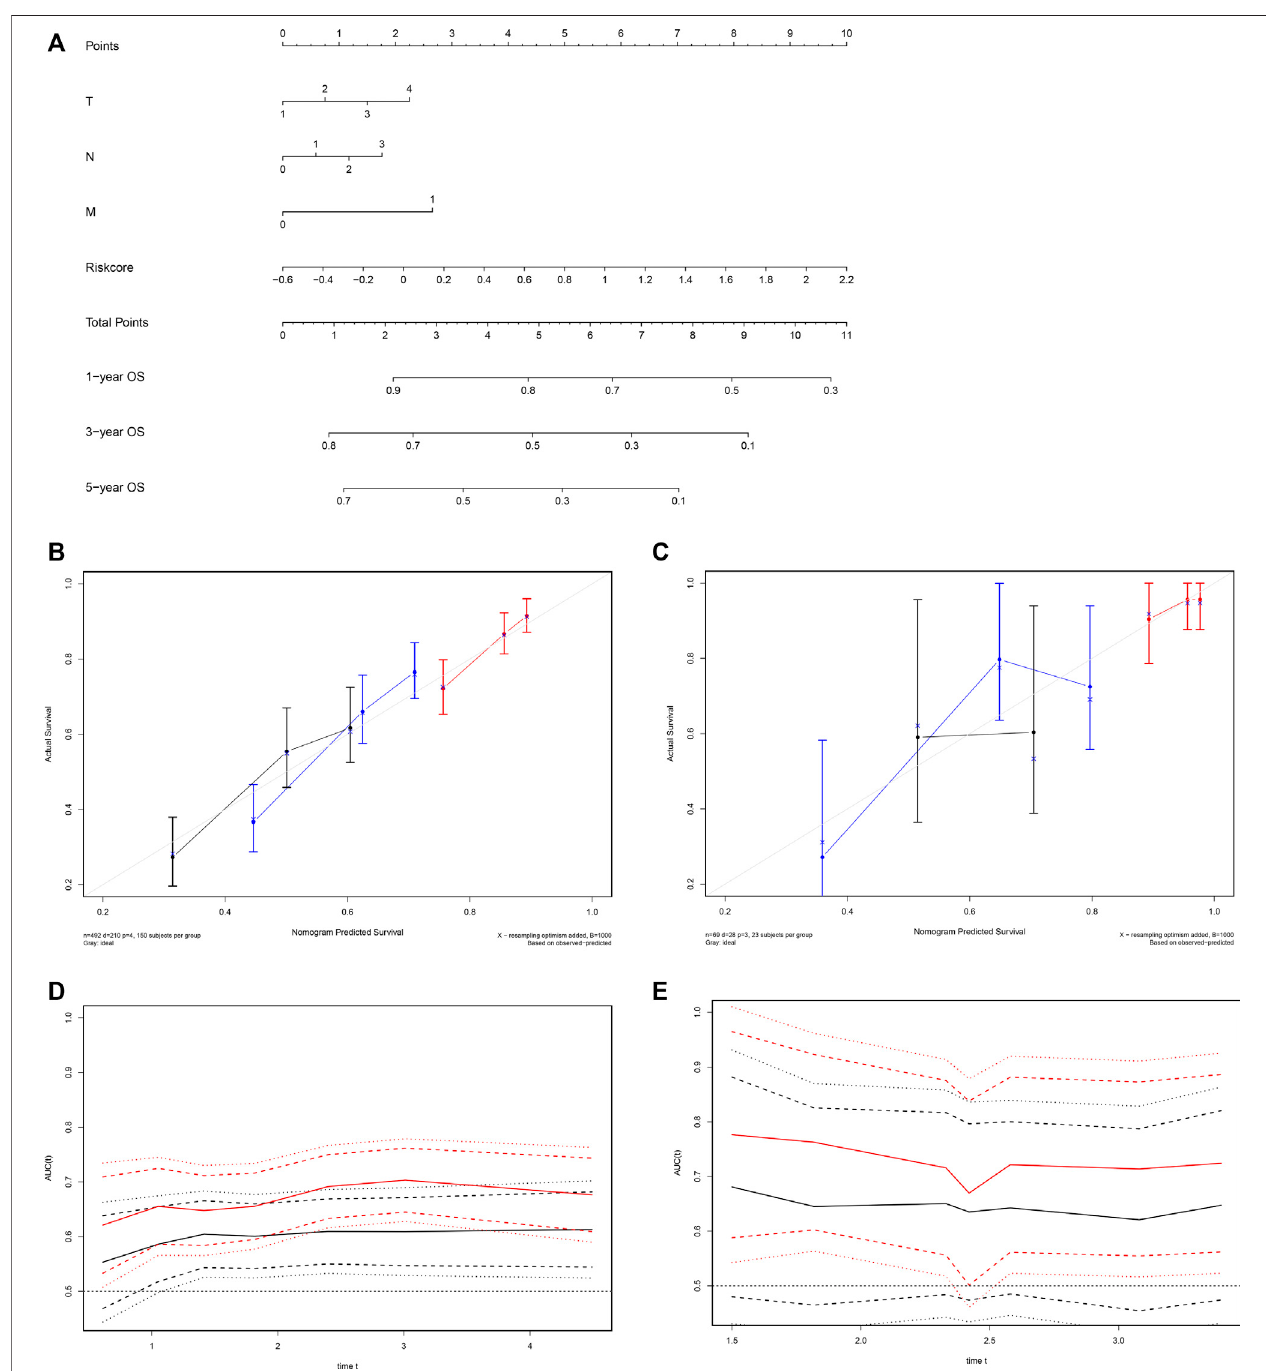
FIGURE8| DevelopmentofanomogrambasedontheARGsignatureforpredictingoverallsurvivalofpatientswithLUSC. (A) ThenomogramplotintegratingARG riskscoreand T-,N-,and M-classi fi cationintheTCGA trainingcohort. (B) Thecalibration plotfortheprobabilityof1-,3-,and5 years OSintheTCGA trainingcohort;1- year: red; 3 years: blue; 5 years: black. (C) The calibration plot for the probability of 1-, 3-, and 5 years OS in the GSE73403 validation cohort; 1 year: red; 3 years: blue; 5 years: black. (D) Time-dependentROCcurves comparing the prognostic accuracyoftheriskscorecombining ARGsand theTNMsystem inthetraining cohort; risk score+TNM:red; TNMonly: black. (E) Time-dependentROC curves comparingtheprognostic accuracy oftheriskscore combining ARGsand theTNM system in the validation cohort; risk score + TNM: red; TNM only: black.